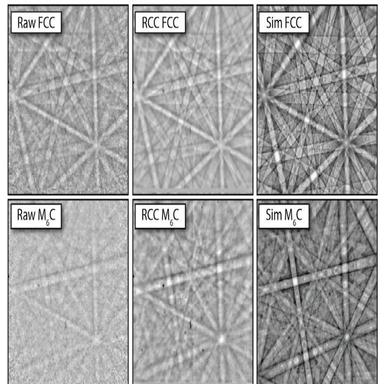
Comparisons of example raw, rotated characteristic component (RCC), and template matched dynamically-simulated EBSPs for the pseudo-FCC Ni/Co matrix and the M6C carbide phase. This demonstrates how the method amplifies the quality of the minor phase substantially, which assists in unambiguous classification.